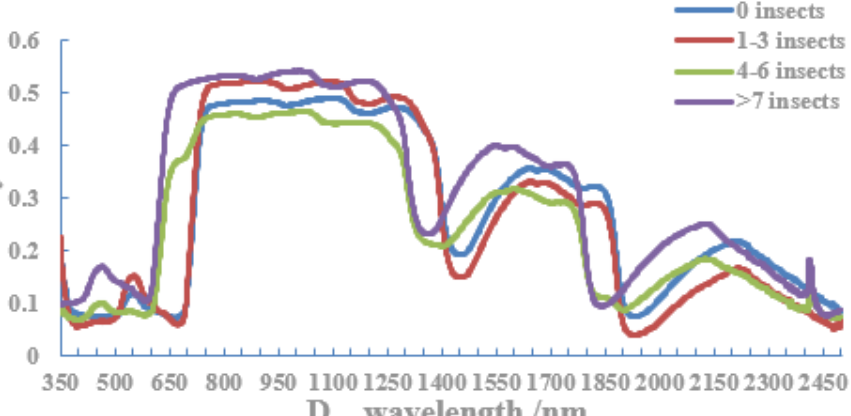
Figure 5. Spectral curves of host leaves with different numbers of adult C. ciliata in different directions (( A ) east; ( B ) south; ( C ) west; and ( D ) north).